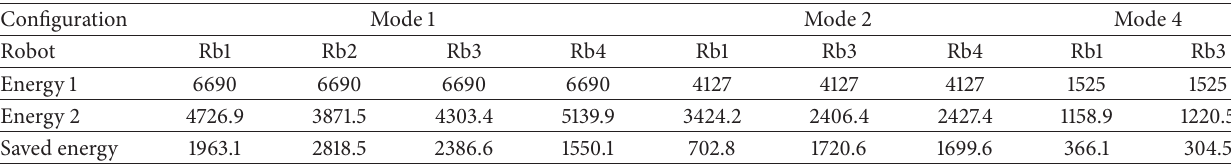
Table 2: Energy consumption of